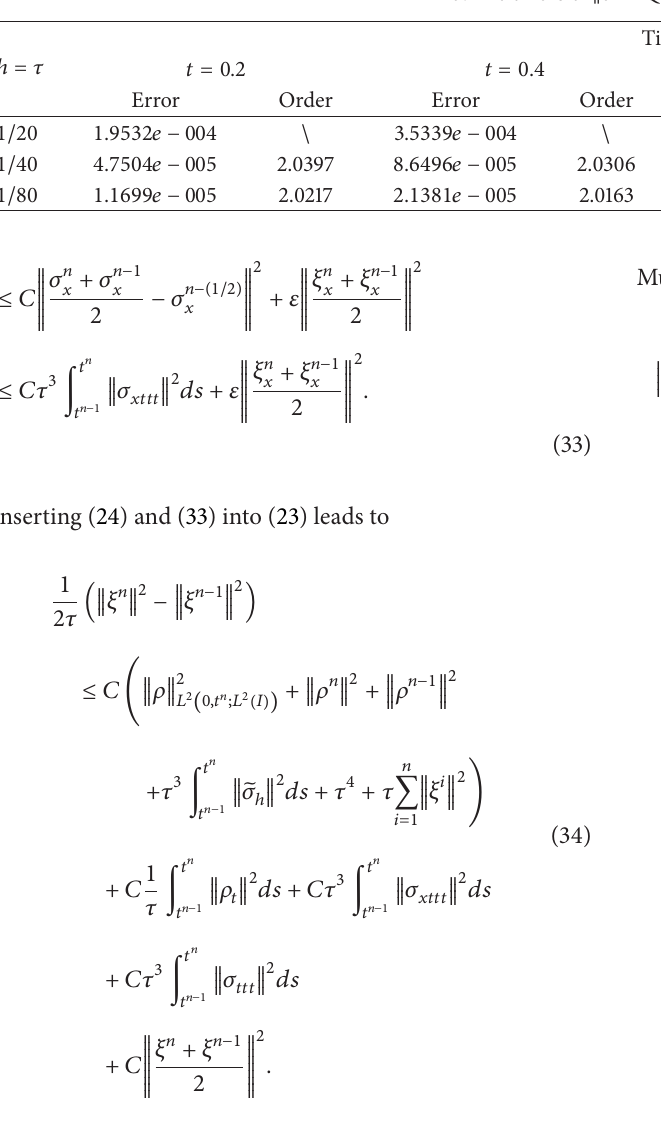
Table 3: The errors of ‖𝜎 𝐽 − 𝑄 𝐽 ‖ at different